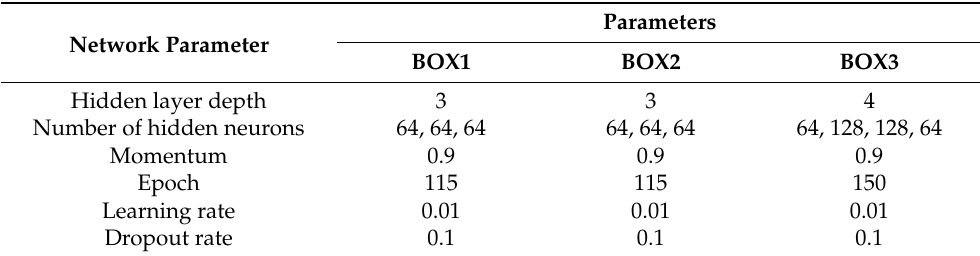
Table 2. Parameters of the IDNN model in three BOXes. Network